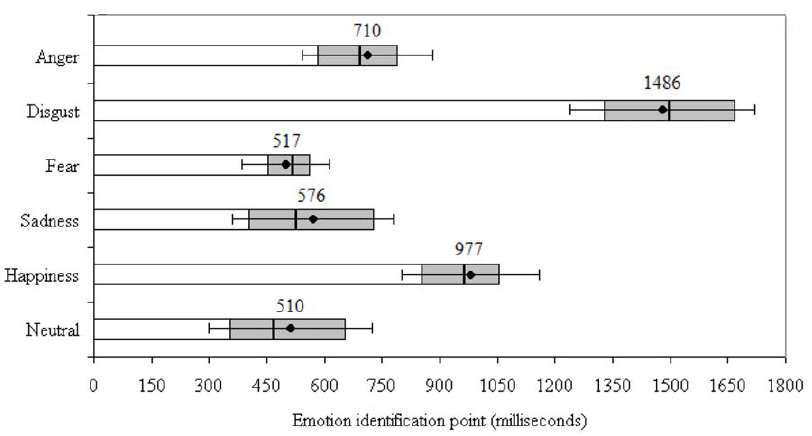
Figure 2. Mean recognition point for utterances conveying each emotion. Error bars refer to the standard deviation around the mean, and shaded bars refer to the 25 th and 75 th percentile within the distribution of identification points for each emotion (minimum of 848 and maximum of 1062 data points calculated per emotion category).